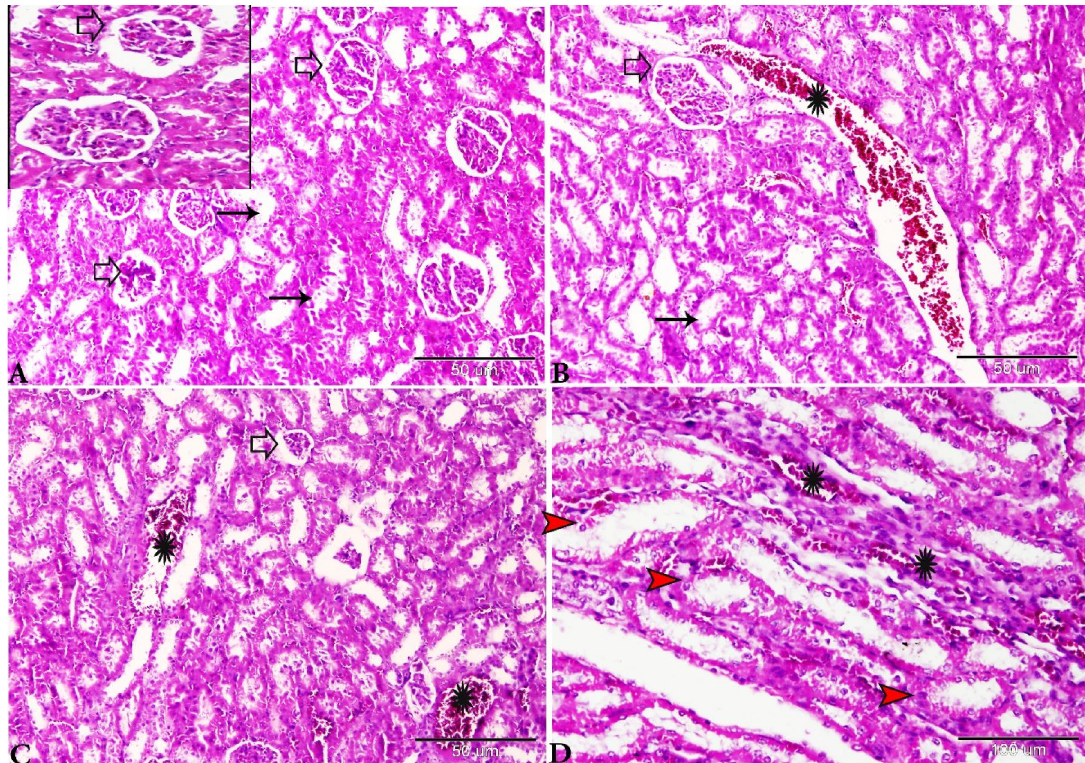
Figure 3. Photomicrograph of the rat kidneys from Group II (treated with basal diet 70% + control cheese 30%). ( A – C ) Glomerular atrophy (thick arrows, maximized in the selected square), degeneration and desquamation of the renal tubular epithelium (thin arrows), and cortical vessels widely dilated and congested (star), ( D ) Renal medulla showing the degeneration of renal tubules (Henle’s loop) (red arrowheads), vascular congestion (stars), and hemorrhage between the renal tubules. H&E stain, the bar size was indicated under